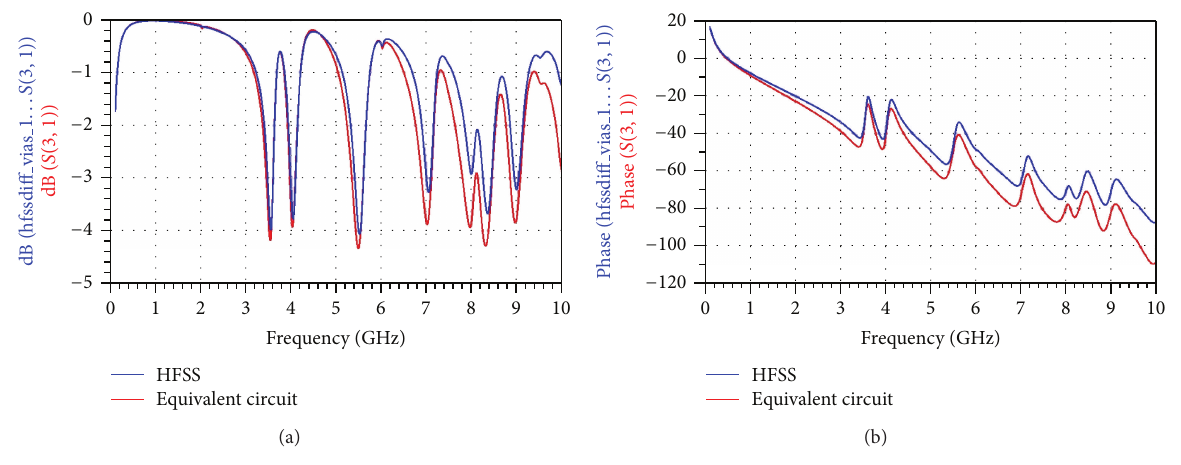
Figure 15: 𝑆 21 of a differential vias structure: (a) amplitude; (b)